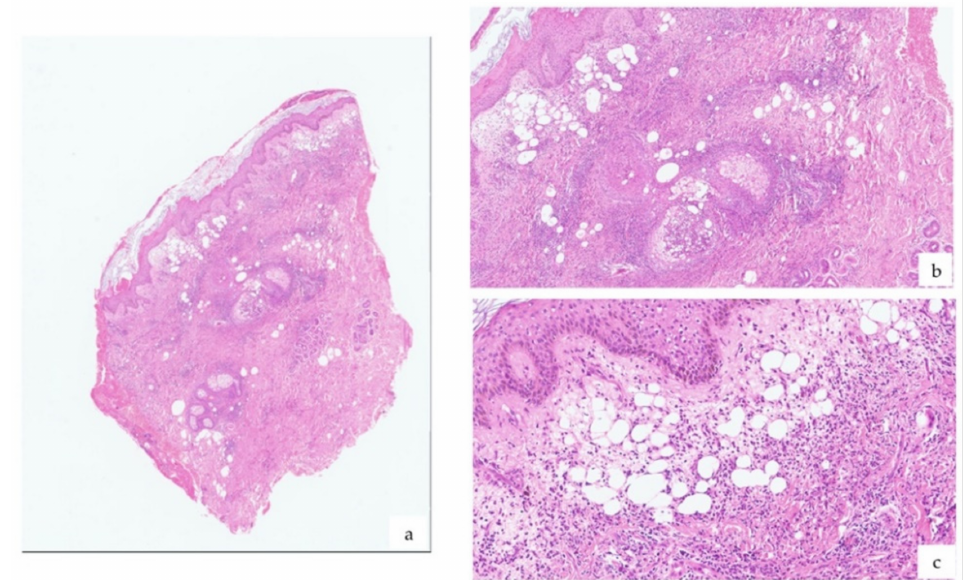
Figure 2. Histopathological examination of a lesion showed a dense inflammatory infiltrate and edema of the papillary dermis ( a ) (H&E); up-close views ( b , c )